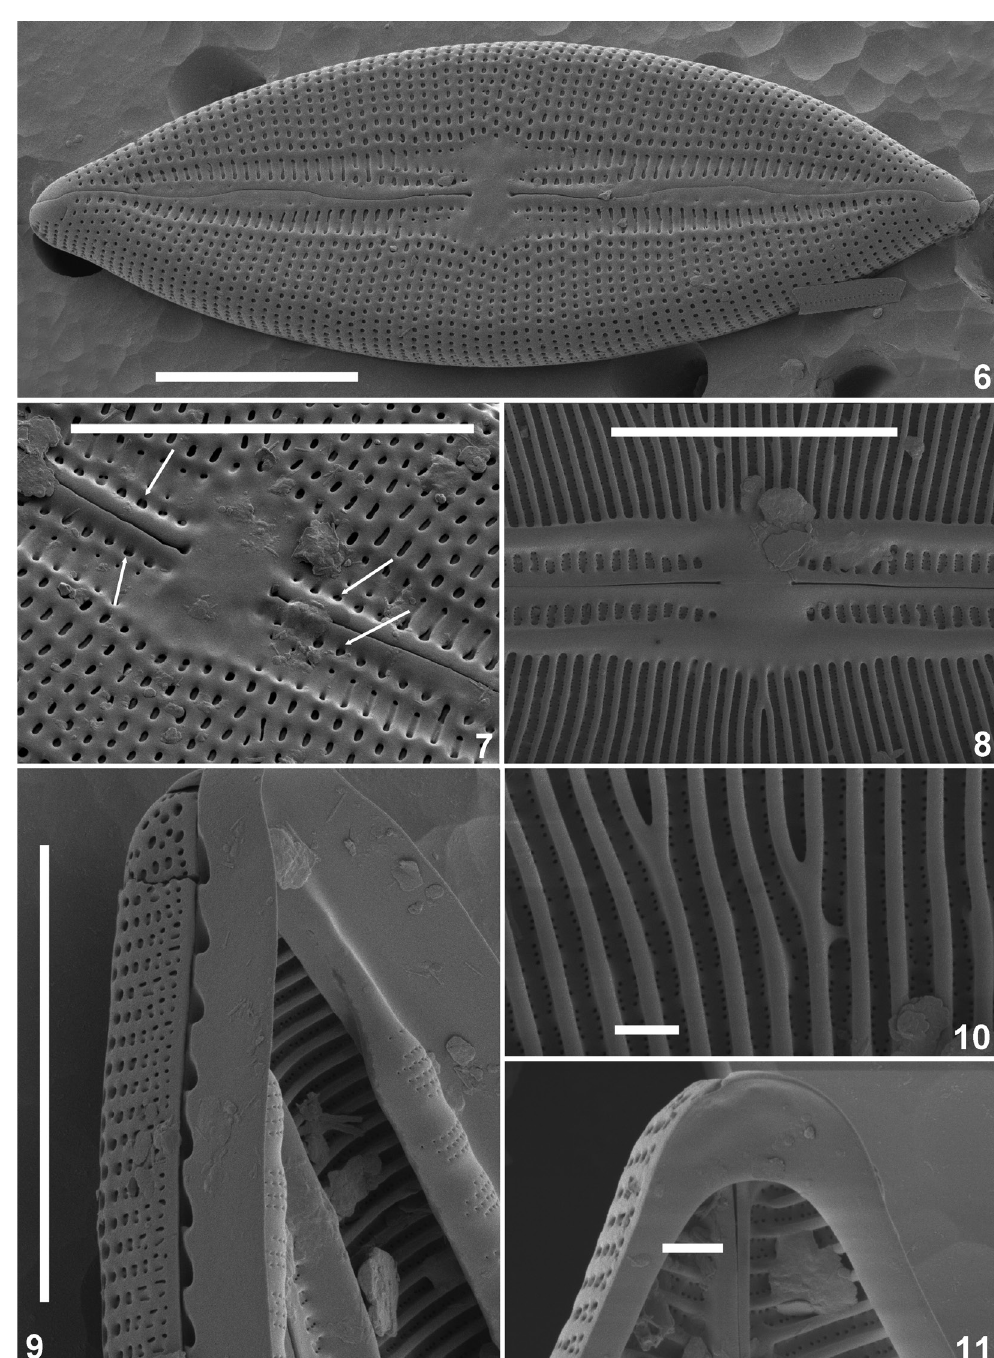
Figs 6–11. Mastogloia braunii Grunow. Scanning electron micrographs (SEM) of valves from the type population ( Grunow 23583 – capsule 0645 , Vienna, Austria). 6 . SEM external view of an entire valve showing the shallow depressions in the axial area, the undulating external raphe branches and the terminal raphe fissures. 7 . SEM external detail of the central area. The arrows indicate one row of irregularly scattered rounded pseudoloculi. 8 . SEM internal detail of the central area. 9 . SEM detail of the valve mantle showing the mantle striae with near the mantle edge, their typical biseriate character. 10 . SEM internal view of the striae with the arrangement of the inner areolae. 11 . SEM internal detail of the valve apex with the pseudoseptum. Scale bars: 6–9 = 10 µm; 10–11 = 1